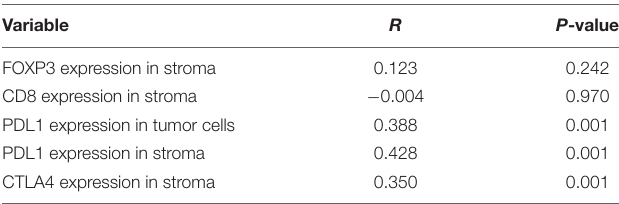
TABLE 5 | Correlation of TGF β 1 expression in cancer associated fibroblasts with other immune indicators in 90 patients with SCLC. Variable R P